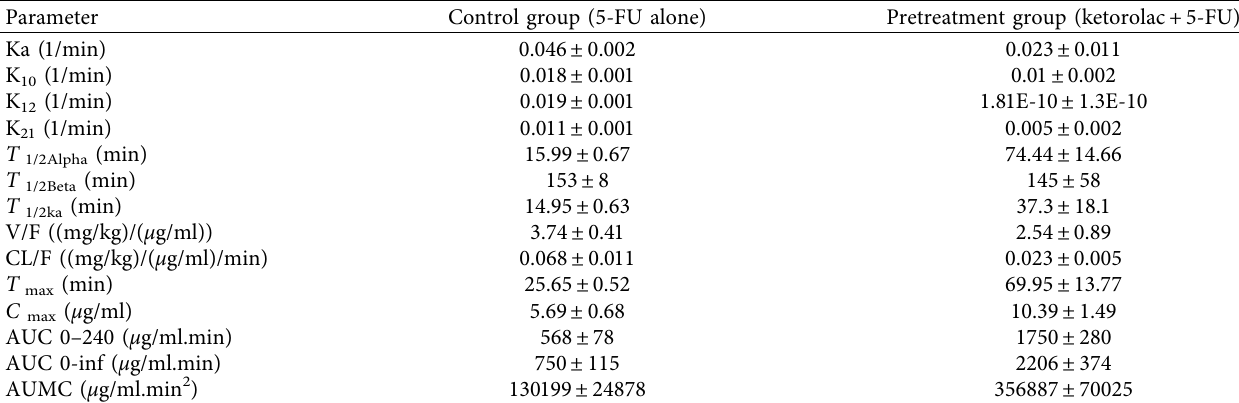
Table 2: Pharmacokinetic parameters of 5-FU (50mg/kg, i.p) in the control group and the pretreatment group as mean ± SD. Parameter Control group (5-FU